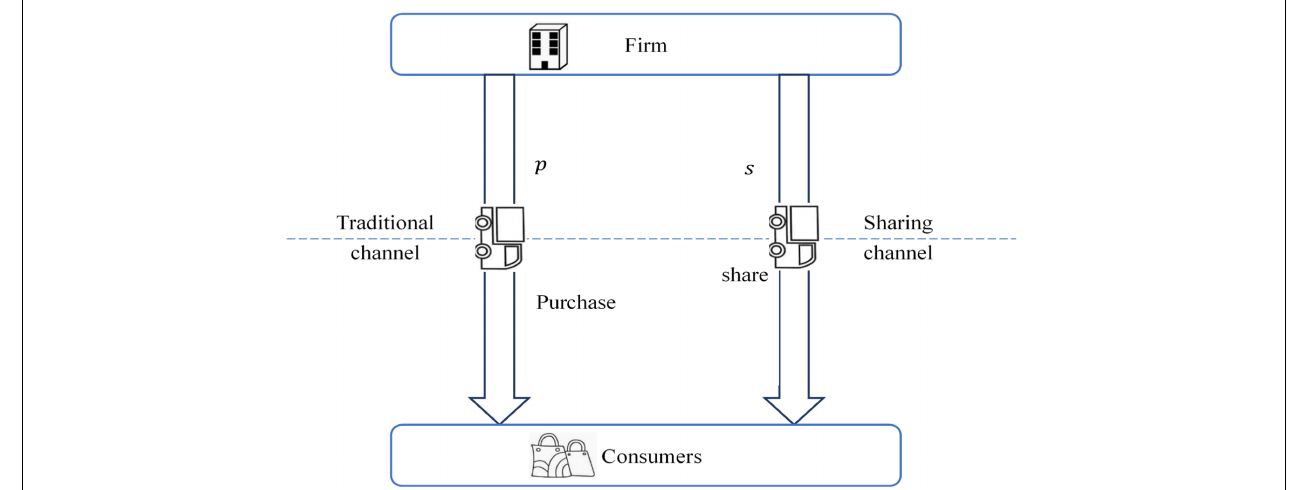
FIGURE 1 | Sequential events.